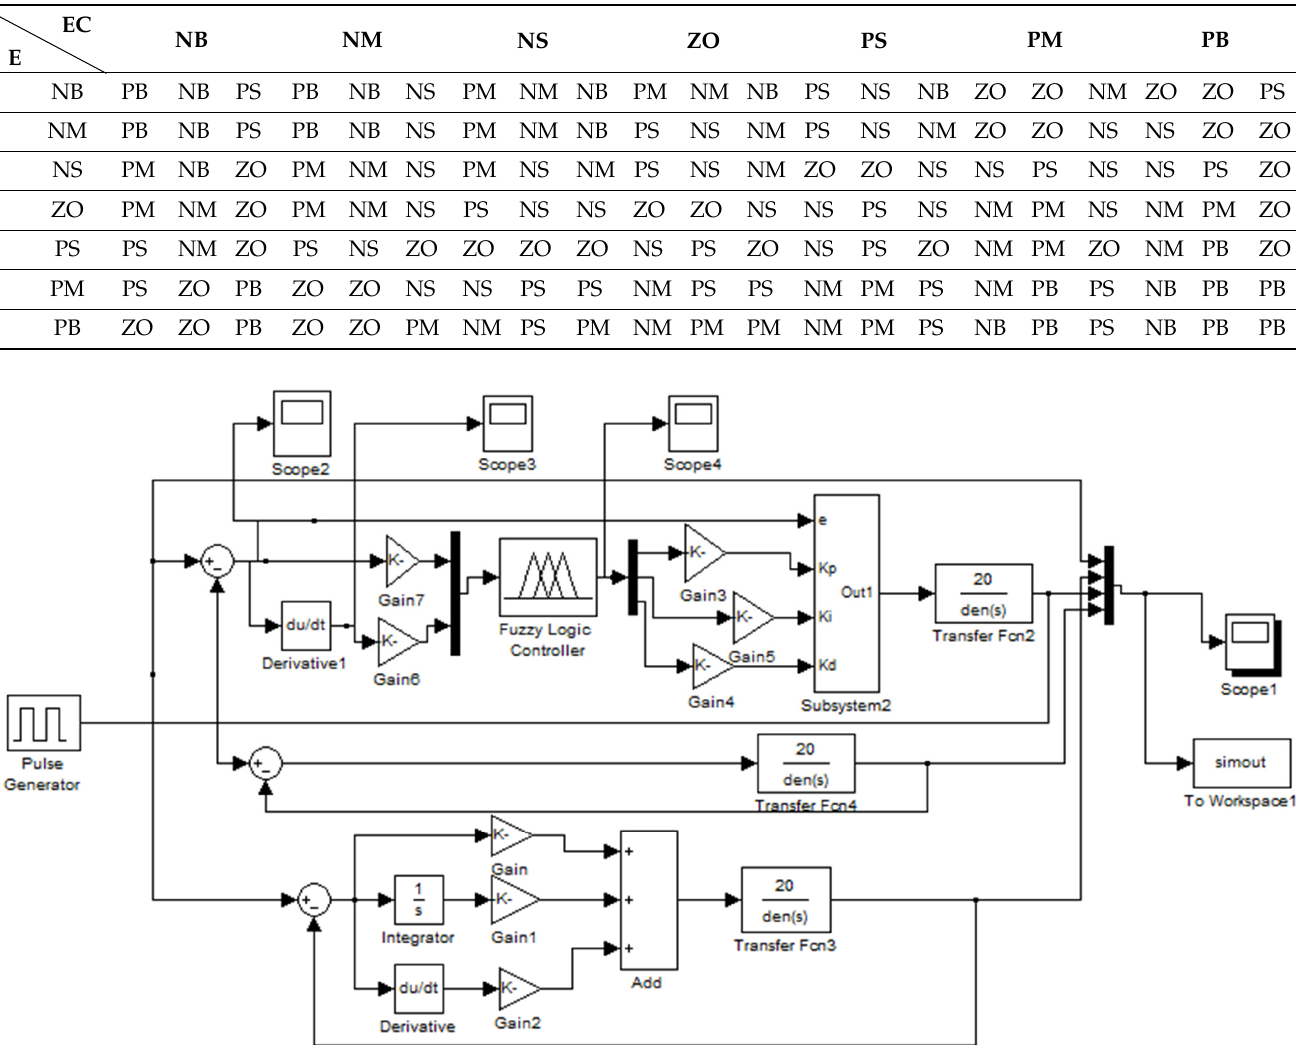
Table 2. Regulation table of fuzzy control.